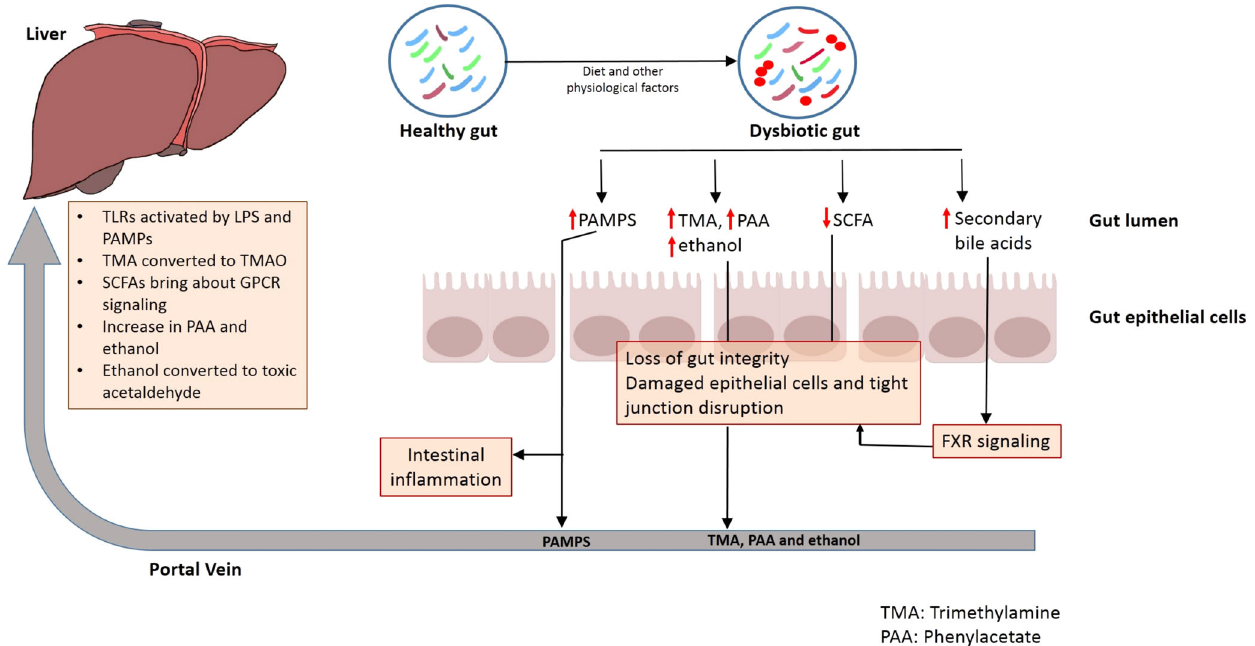
Fig. 1 Translocation of metabolites in Gut – liver axis. Translocation of metabolites and pathogen associated molecular patterns (PAMPs) biosynthesized by microbes in the gut through the portal circulation to liver where they exert multiple effects on liver health